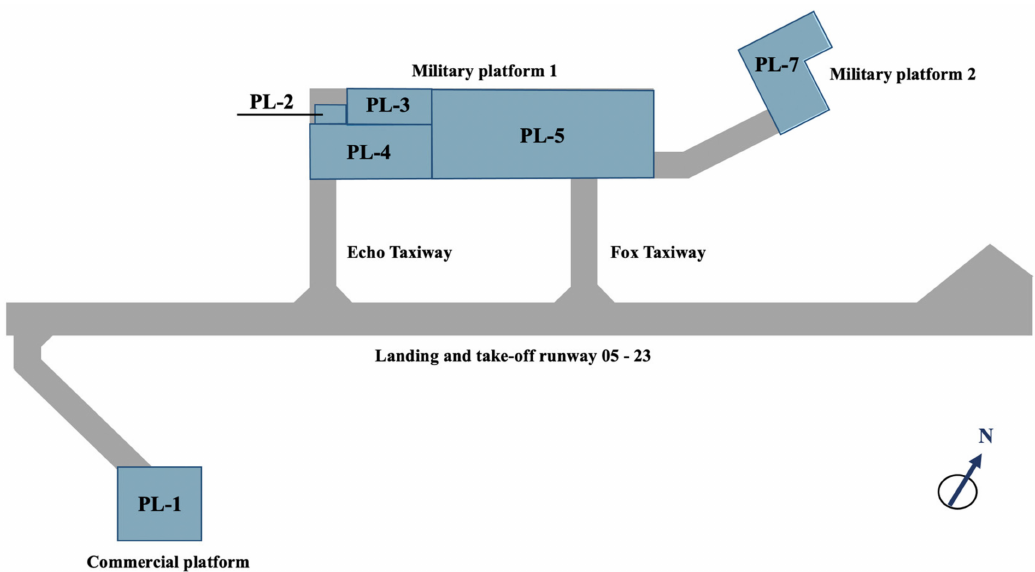
Figure 9. Emplacement of concrete pavements analyzed in the Airport of Viña del Mar.